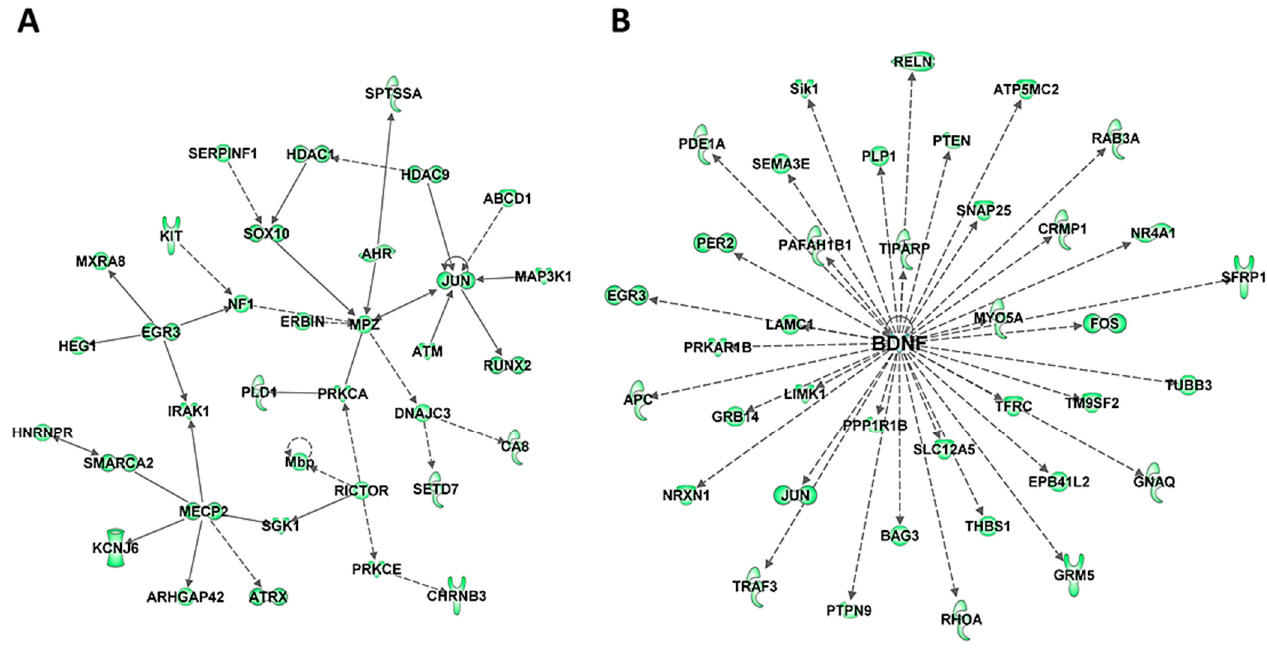
Figure 4. Biological networks of predicted mRNA targets of upregulated miRNAs in HuD KO striatum. The predicted target mRNAs of upregulated miRNAs (Tables S4 and S5) were analyzed by IPA. ( A ) One of the top biological networks with target mRNAs is associated with cell death and survival, neurological disease, and organismal injury and abnormalities (Table S5). ( B ) Another top biological network of predicted miRNA targets is related to BDNF. Keys of the biological functions corresponding to the protein symbols in the networks are shown at the bottom of Figure 2 and in Figure S3E.